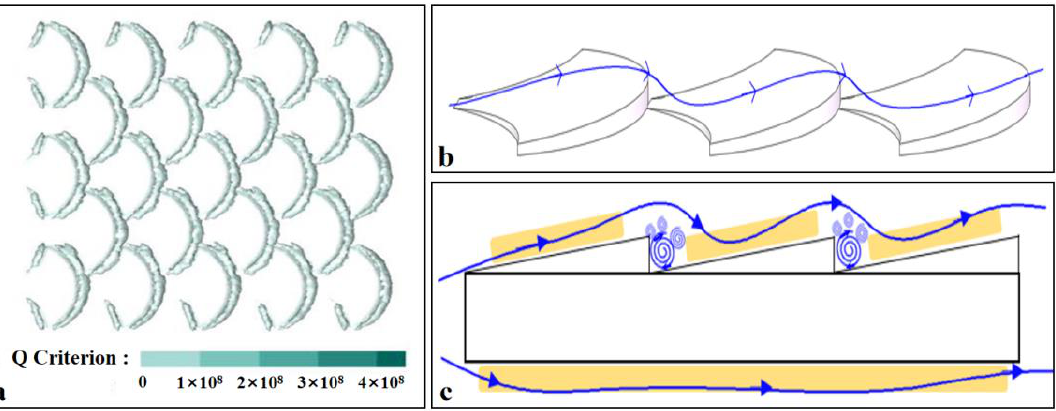
Figure 24. The vortices distribution and the streamline of the x-y cross section. ( a ) Vortices diagram generated according to the Q criterion; ( b ) The streamline on the surface; ( c ) Schematic diagram of the contact surface between liquid and a solid.